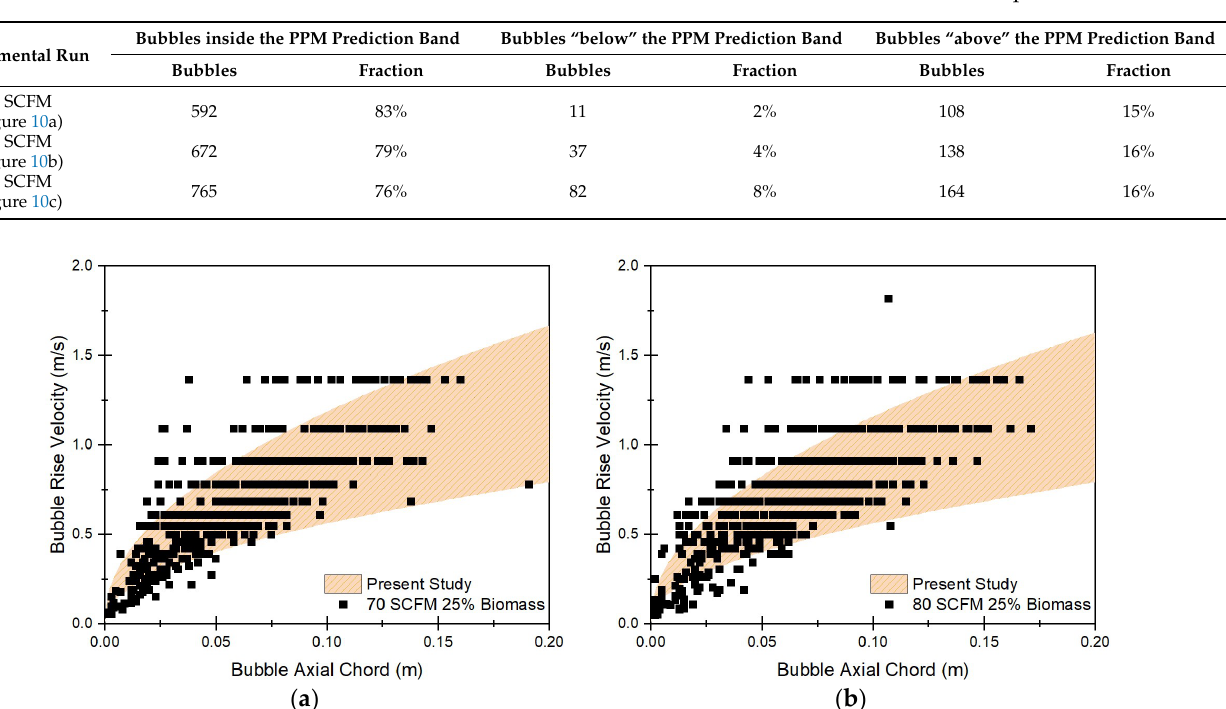
Figure 11. BRVs and BACs for bubbles measured in the bubbling regime, with 25 vol% biomass, in a sand bed, under volumetric airflows of: ( a ) 70 SCFM, and ( b ) 80 SCFM. Notes: (i) data points were obtained using the CREC-Optiprobes and the proposed HSCE model [19]; (ii) the probabilistic predictive model (PPM) is reported with an orange band. Table 3. Bubble number and bubble number fractions with BRVs and BACs falling inside the PPM bands, as well as below and above the PPM bands. Note: the sand bed has 25 vol% biomass pellets. Experimental